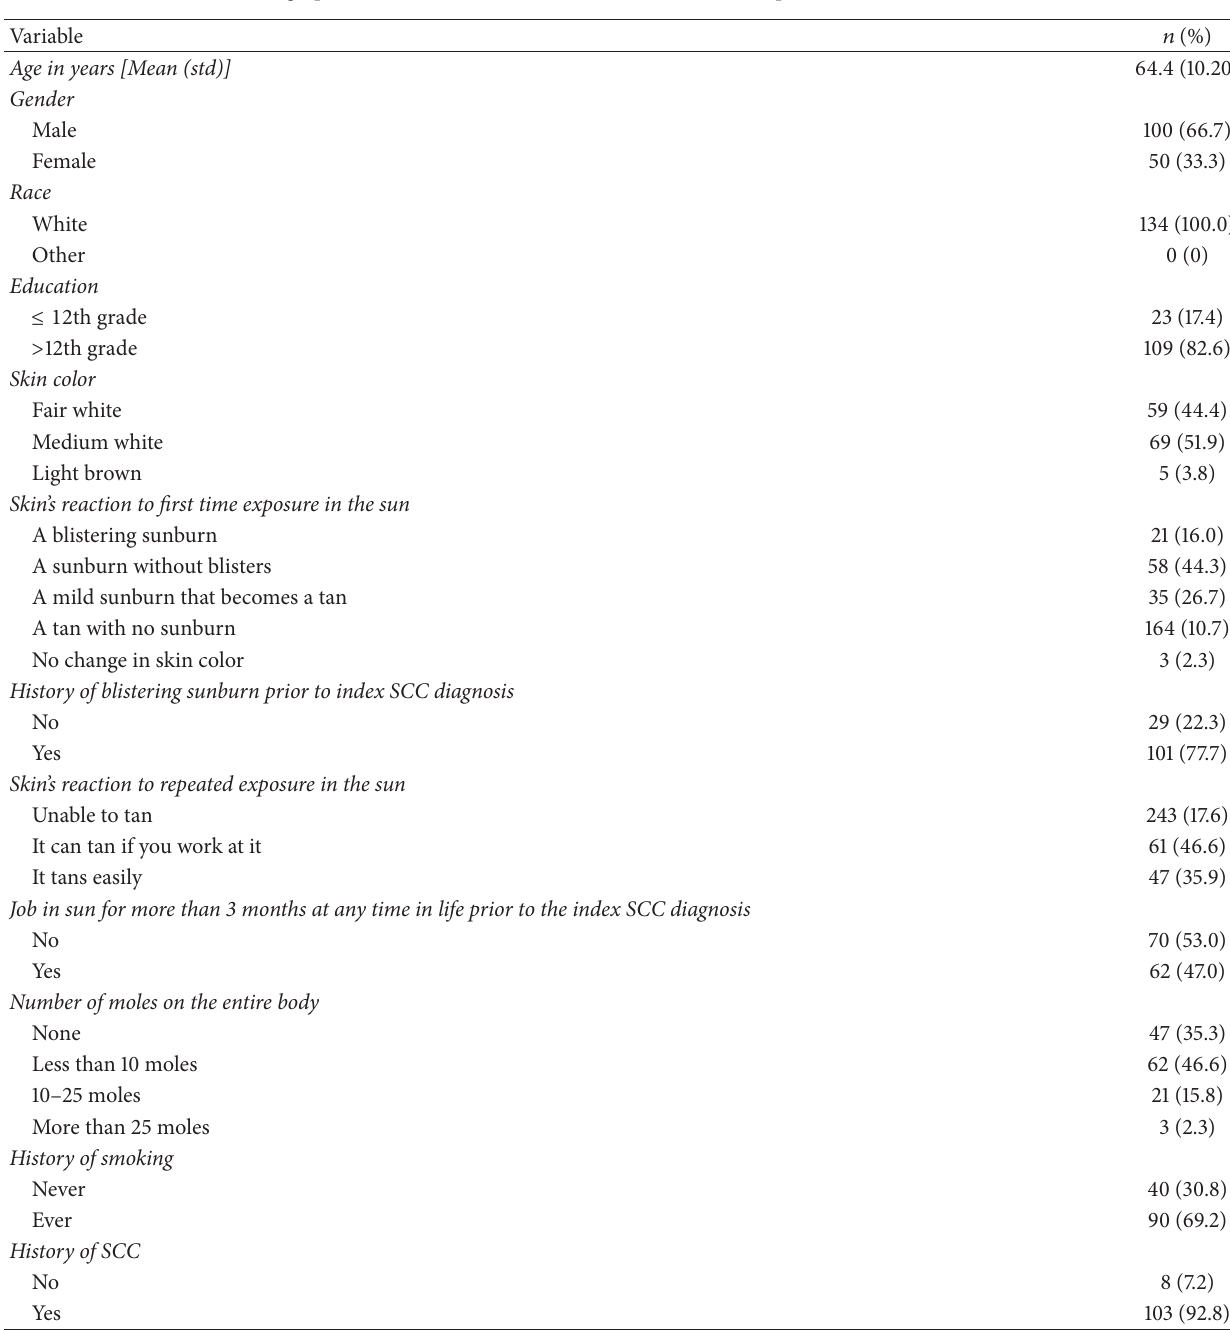
Table 1: Demographic and baseline characteristics of 150 cutaneous squamous cell carcinoma (SCC)